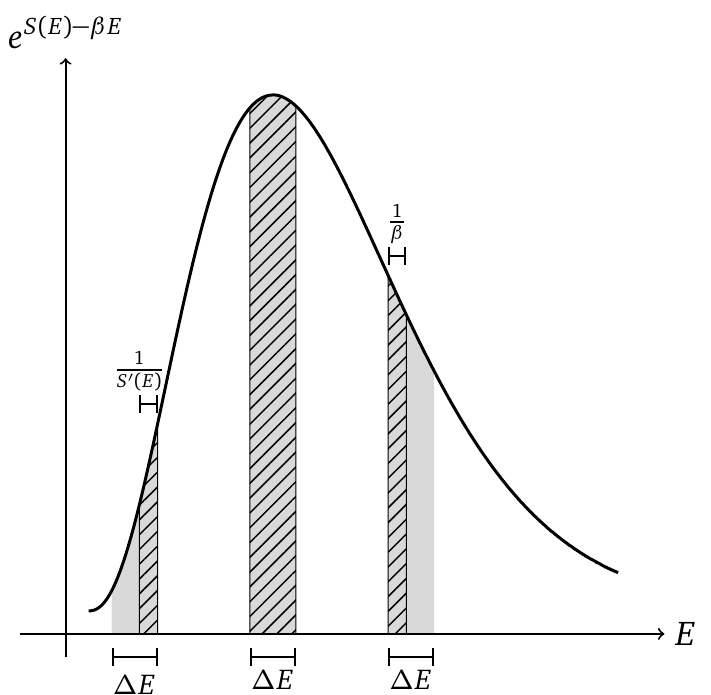
Figure 1: Statistical ensemble corresponding to | MCTFD 〉 . The function g selects a window of energy states in an auxiliary Boltzmann distribution. We pick three windows (shaded areas), corresponding to the regimes explained in the text. From ) , ( S ′ ( E ) − β ) ∆ E ≪ 1 and β ≫ S ′ ( E ) . The dashed areas left to right: β ≪ S ′ ( E 0 0 0 correspond to the states that dominate the ensemble in the different regimes. The energy uncertainty is determined by these states